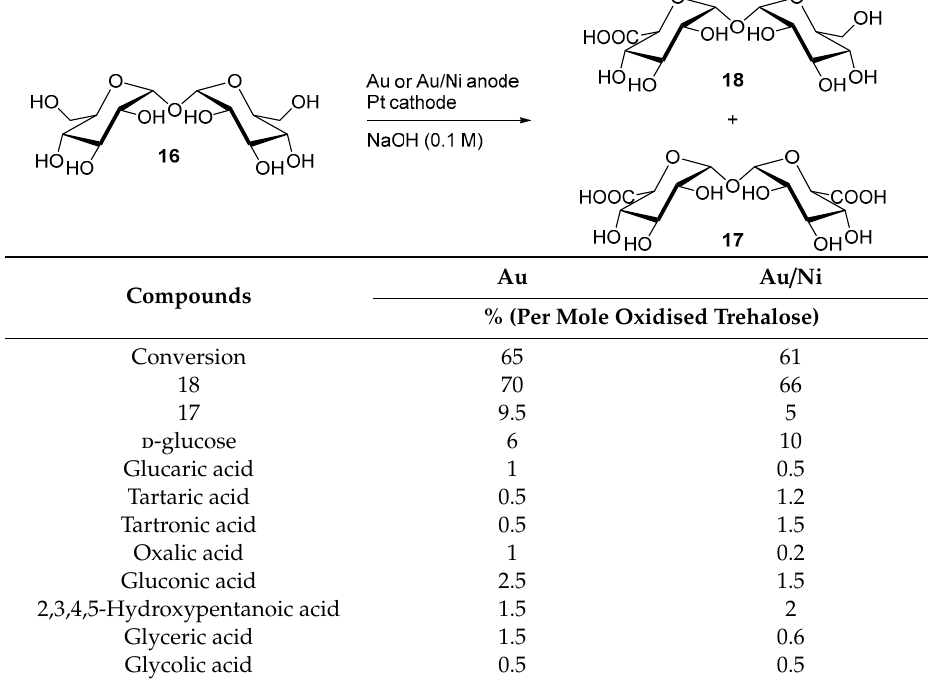
Table 2. Product distribution after electrolysis of trehalose in alkaline media at gold and gold/nickel (70/30) electrodes.